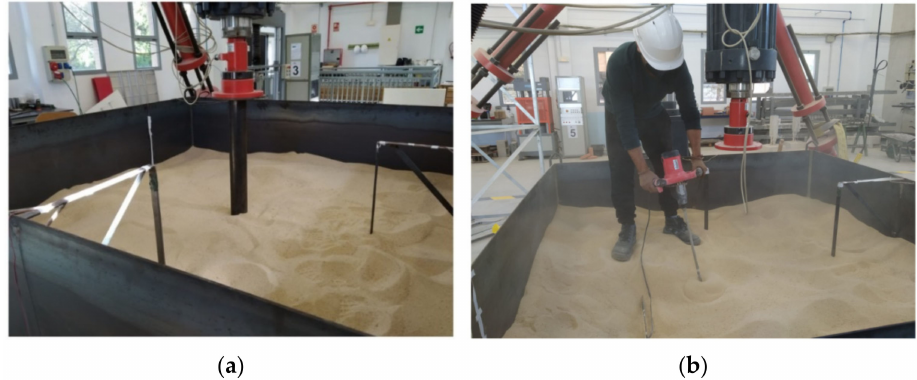
Figure 12. Project phases: ( a ) testing a pile of 80 mm; ( b ) decompaction of the sand.